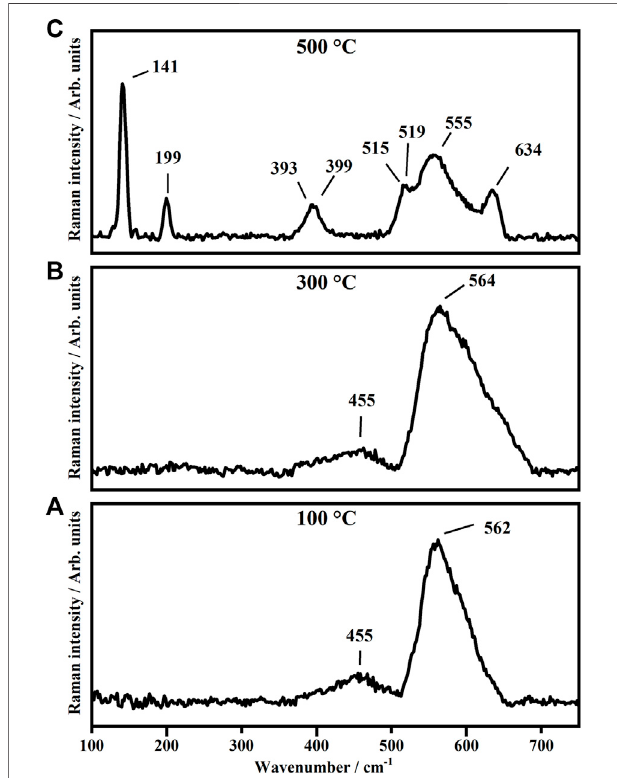
FIGURE 2 | Representative Raman Spectra collected on TiO 2 thin fi lms annealed, for 1 h, at 100 ° C (A) , 300 ° C (B) and 500 ° C (C) .